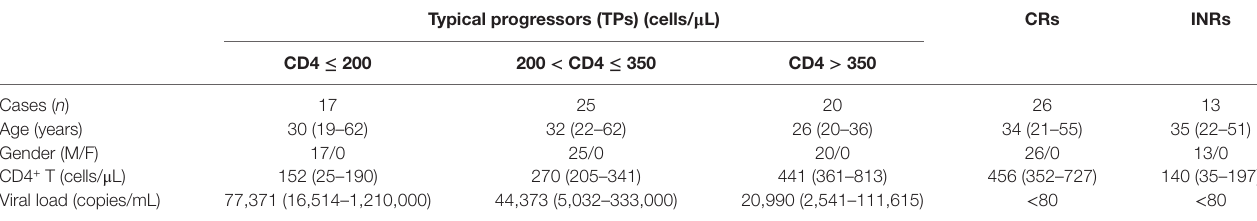
TaBle 1 | Subject